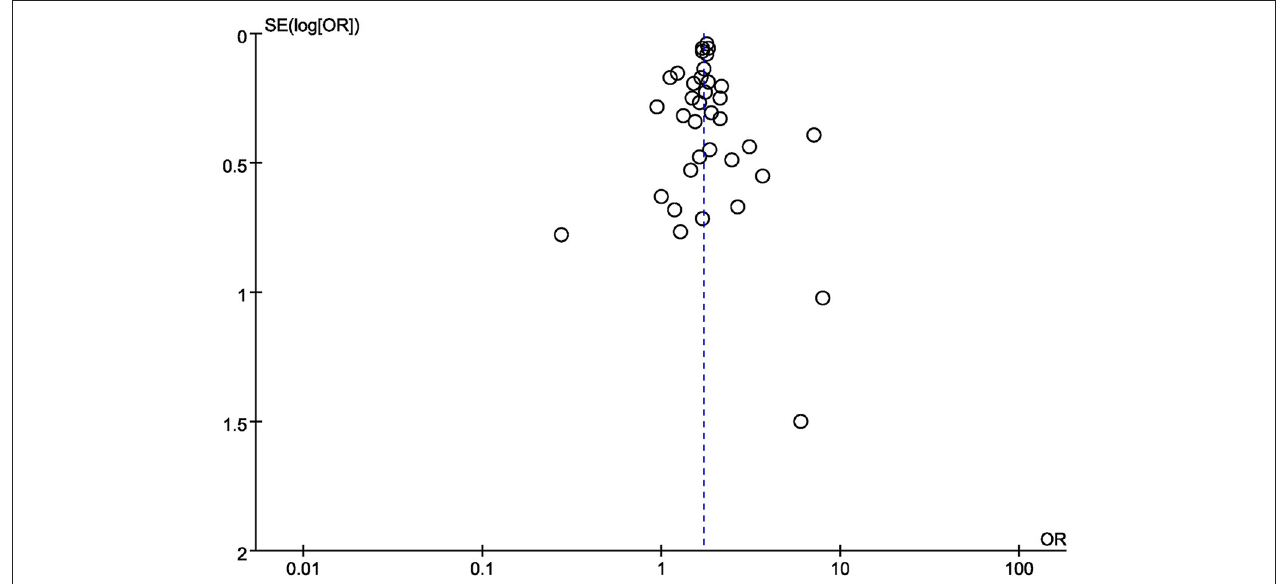
FIGURE 5 | Funnel plot for the relationship between diabetes and the development of AKI in COVID-19